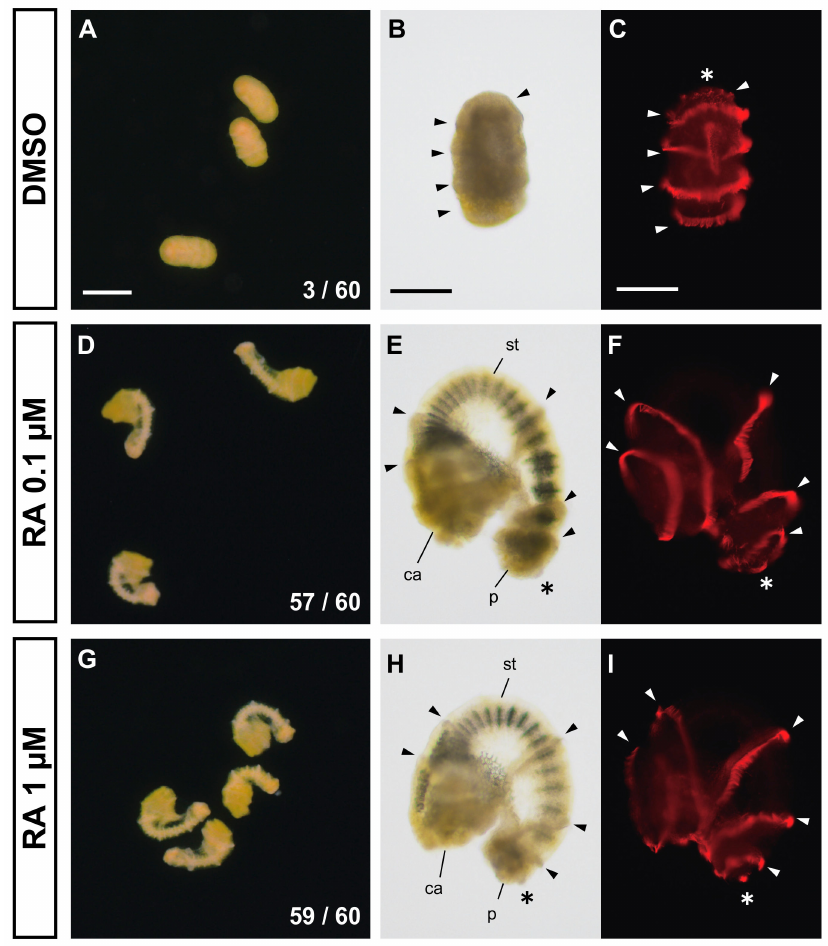
Figure 3. Induction of metamorphosis by exogenous RA treatment. ( A – I ) respectively show the larvae treated for 96 h with DMSO, RA 0.1 µ M and RA 1 µ M. While almost all doliolaria larvae did not metamorphose to cystidean larvae ( A ), metamorphosis was induced by the treatment of RA 0.1 µ M and RA 1 µ M ( D and G , respectively). The numbers in ( A , D , G ) refer to “the number of metamorphosed larvae” / “the number of treated larvae”. ( B , C , E , F , H , I ) indicate the fixed larvae labeled with anti-acetylated tubulin antibody after DMSO, RA 0.1 µ M and RA 1 µ M treatment, respectively (light field; B , E and H , observation of fluorescence; C , F and I ). In RA treatment, metamorphosis was induced as the calyx (ca), stalk (st) and adhesive plate (p) can be clearly observed, whereas ciliary bands (arrowheads) and apical tuft (asterisk) did not disappear ( E , F , H , I ) like in doliolaria larvae with DMSO treatment ( C ). Scale bars: 250 µ m ( A ), 125 µ m ( B , C